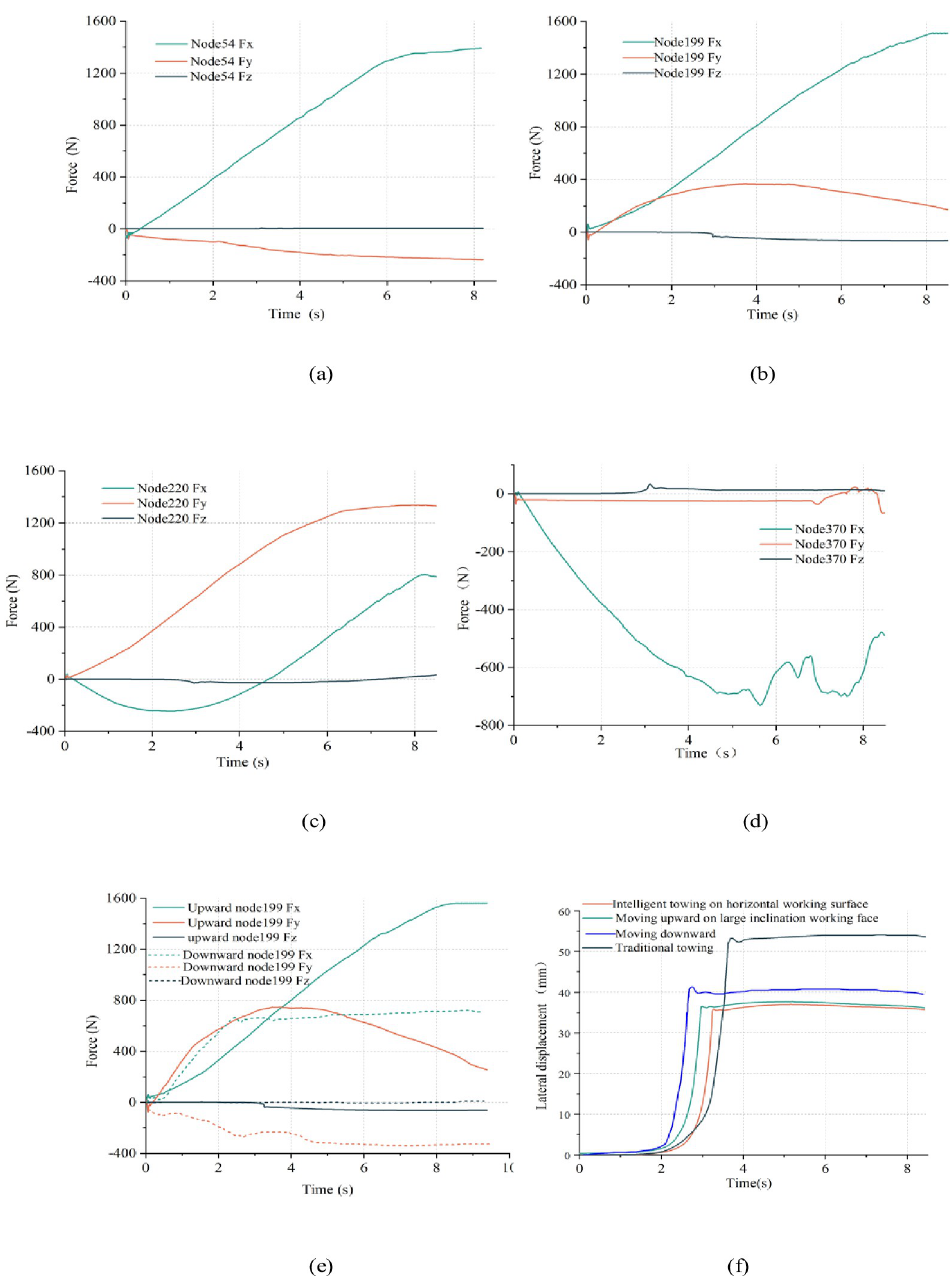
Fig 18. Dynamic gradient changes of the cable: (a) three-dimensional force in area a; (b) three-dimensional force in area b; (c) three-dimensional force in area c; (d) three-dimensional force in area d; (e) comparison of towing upward and downward at large inclination; (f) comparison of lateral displacement with different towing